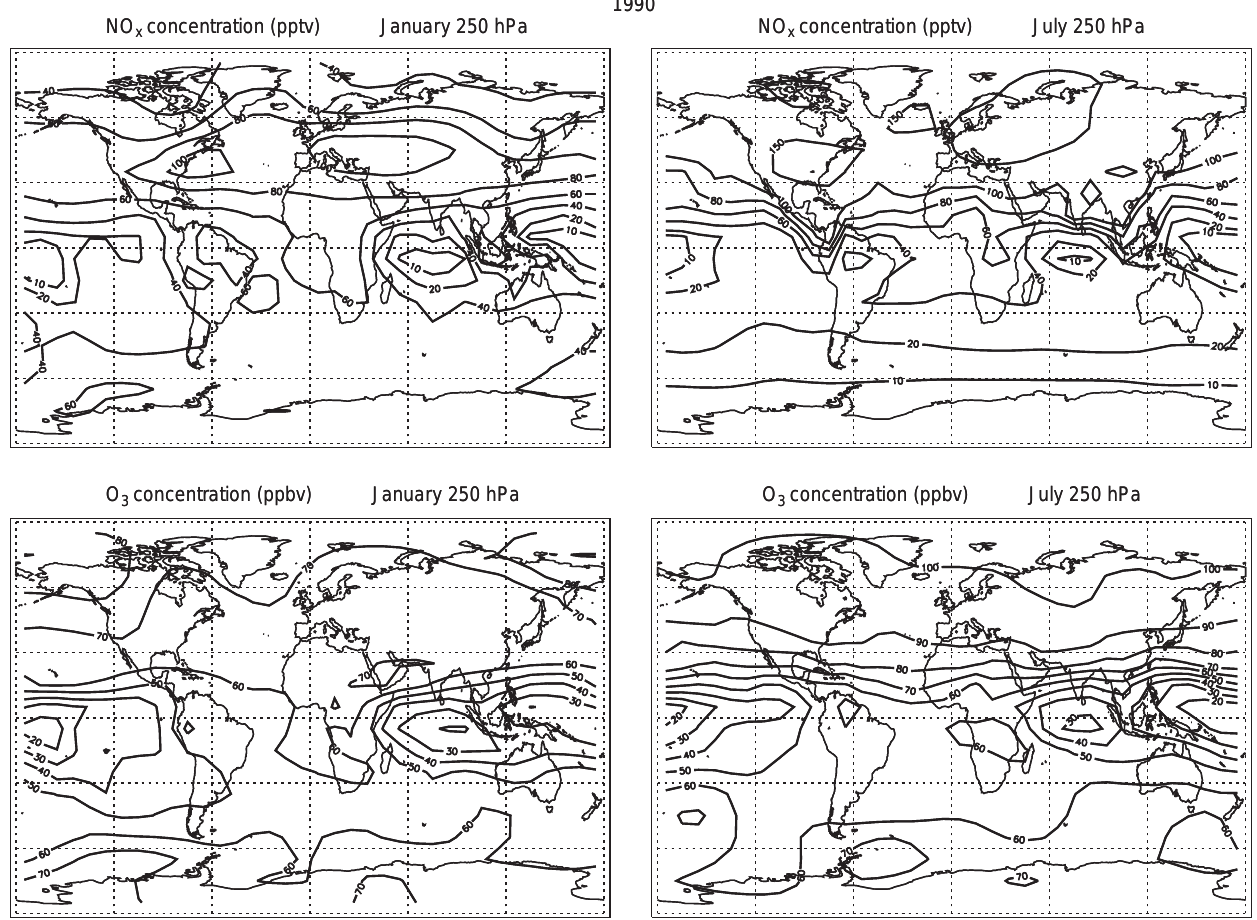
Fig. 2. Distribution of the NO 1990. The figures are for January